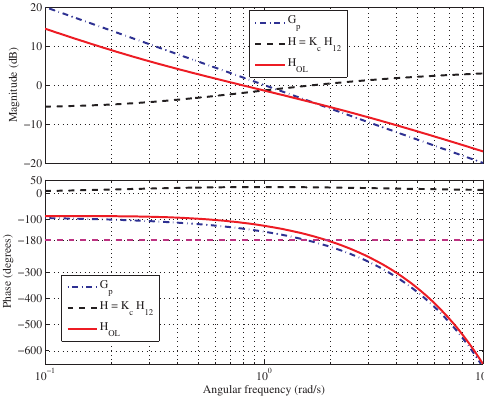
Figure 7. Frequency response by the first plant G p 1 (dash-dotted lines), the compensator H with the CS-FLEC (dashed lines) and the compensated system H OL (solid lines).